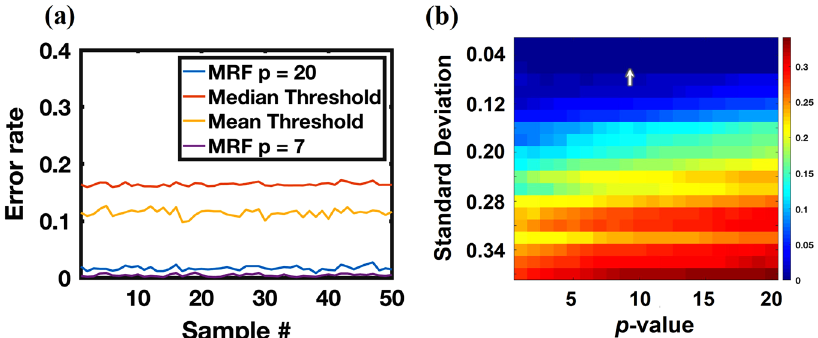
Fig. 4 Analysis of MRF error rate. a Comparison of error rates, determined as a proportion of misidenti fi ed bowl-up and bowl-down conformations, for MRF analysis with two different p values (7 and 20), median thresholding, and mean thresholding. b Error rate as a function of standard deviation of normalized STM intensity distributions and an optimization parameter ( p -value). The arrow shows the value of these parameters in the synthetic data used in Fig. 3b,